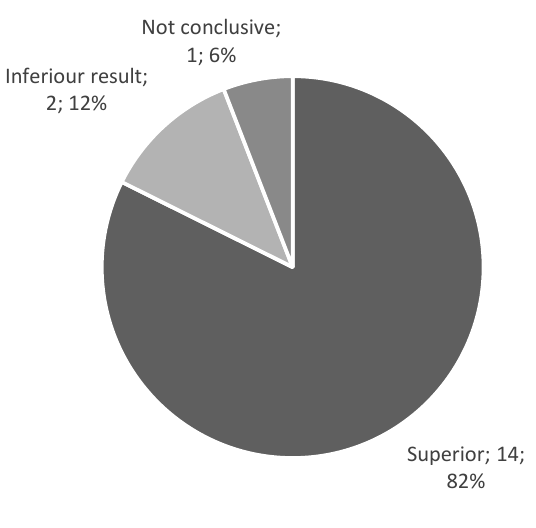
Figure 5. DL model result vs comparison